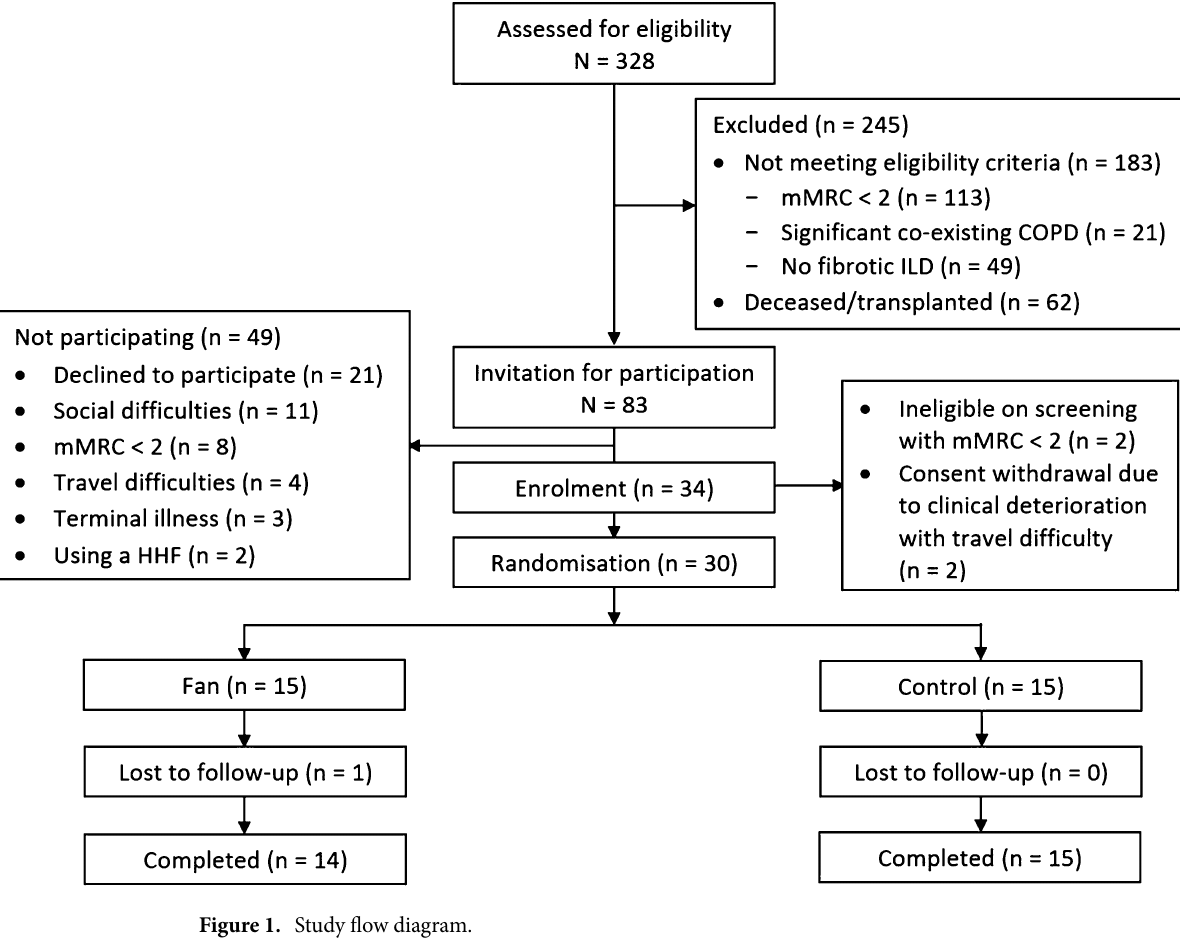
Figure 1. Study flow